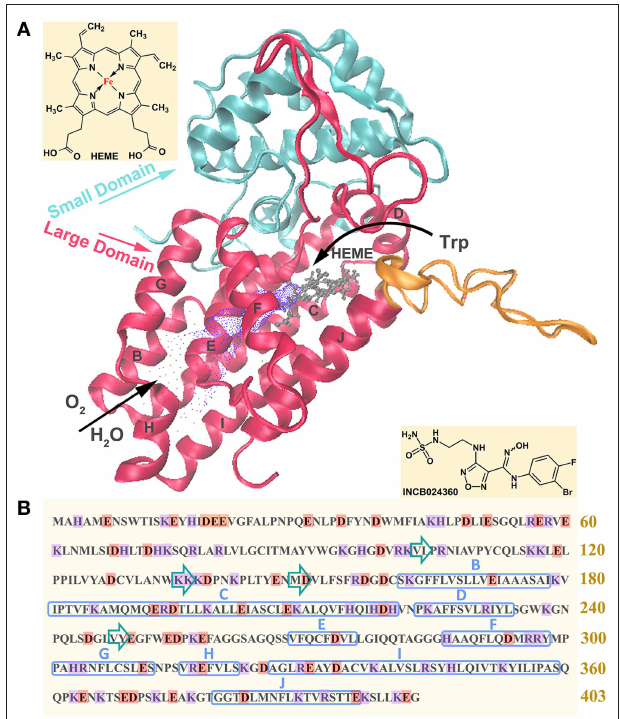
FIGURE 1 | Representation of tertiary (A) and primary (B) structures of IDO1. In figure (A) , blue and red represent the small domain and large domain, respectively; ligand delivery tunnel is colored in purple, where O 2 and H 2 O pass through to heme active center; the substrate/product shuttle channel is colored in orange, where Trp passes in and out the catalytic site; the active site containing heme is colored in gray. In figure (B) , acidic amino acids are marked in orange and basic amino acids are marked in purple; α helixes and β sheets are respectively marked with blue rectangle and green